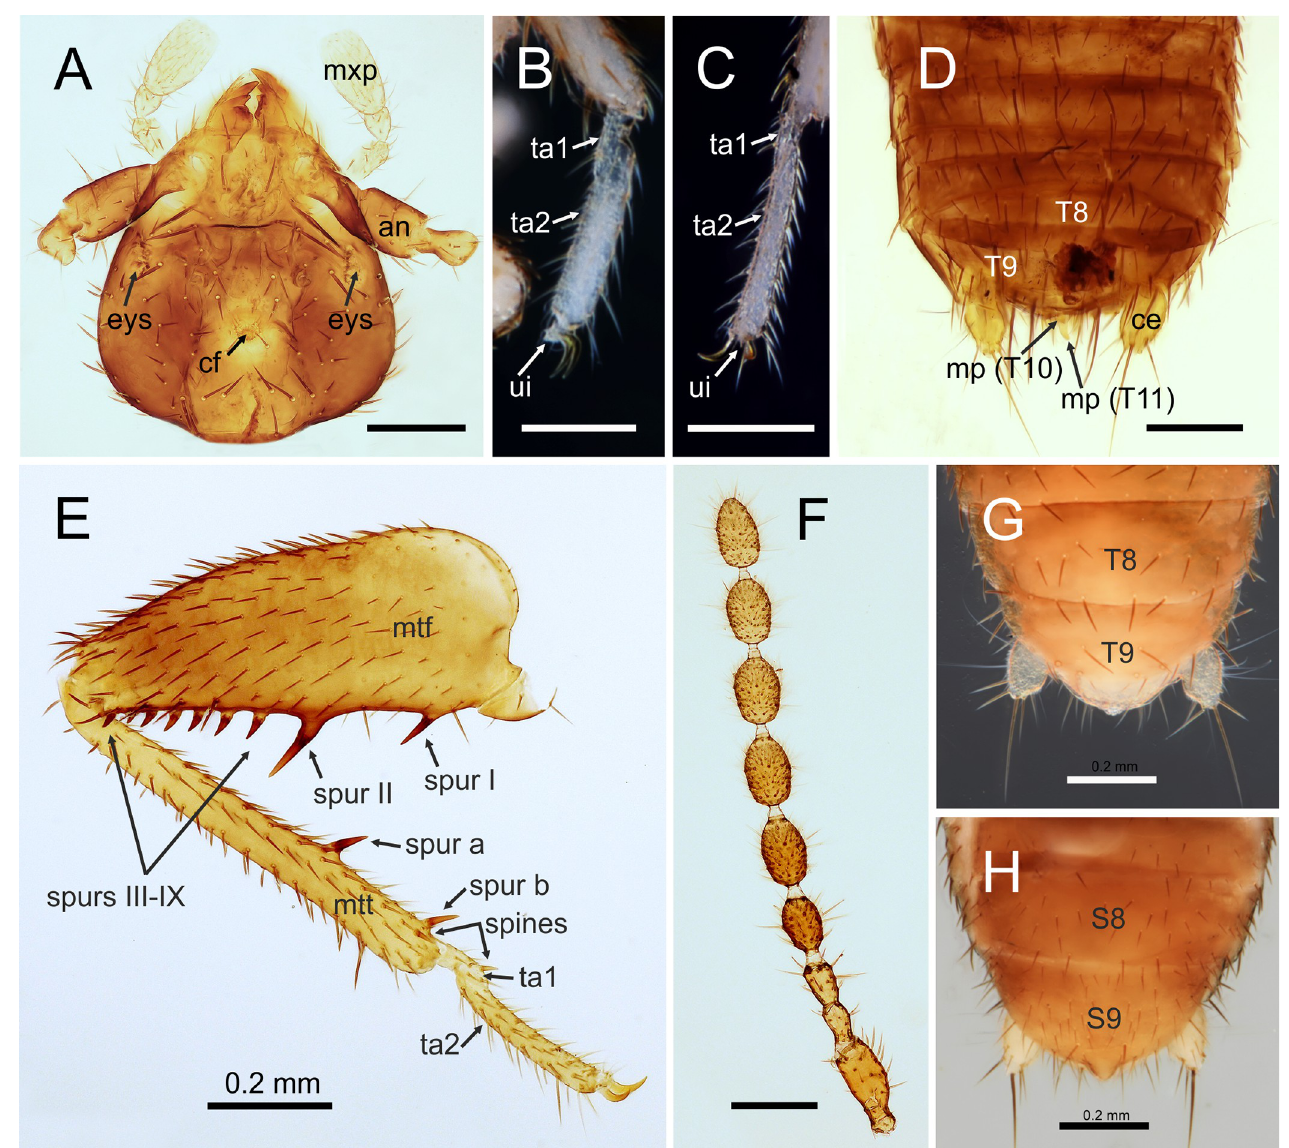
Fig 6. Latinozoros gimmeli sp. nov., apterous male and female paratypes. A: Head of male, dorsal view; B: Tarsi of right foreleg, female; C: Tarsi of left hind leg, female; D: Posterior segments of male abdomen, dorsal view; E: Right metaleg of male, lateral view.; F: Left antenna of male, dorsal view; G: Posterior segments of female abdomen, dorsal view; H: Posterior segments of female abdomen, ventral view. Abbreviations: an–antenna; eys–eye spot; ce–cercus; cf– cephalic gland; ct–ctenidium; mp–median up-curved projection; mtf–metafemur; mtt–metatibia; mxp–maxillary palp; ta–tarsus; ui–unguitractor plate; S– abdominal sternite; T–abdominal tergite. Scale bars = 0.2